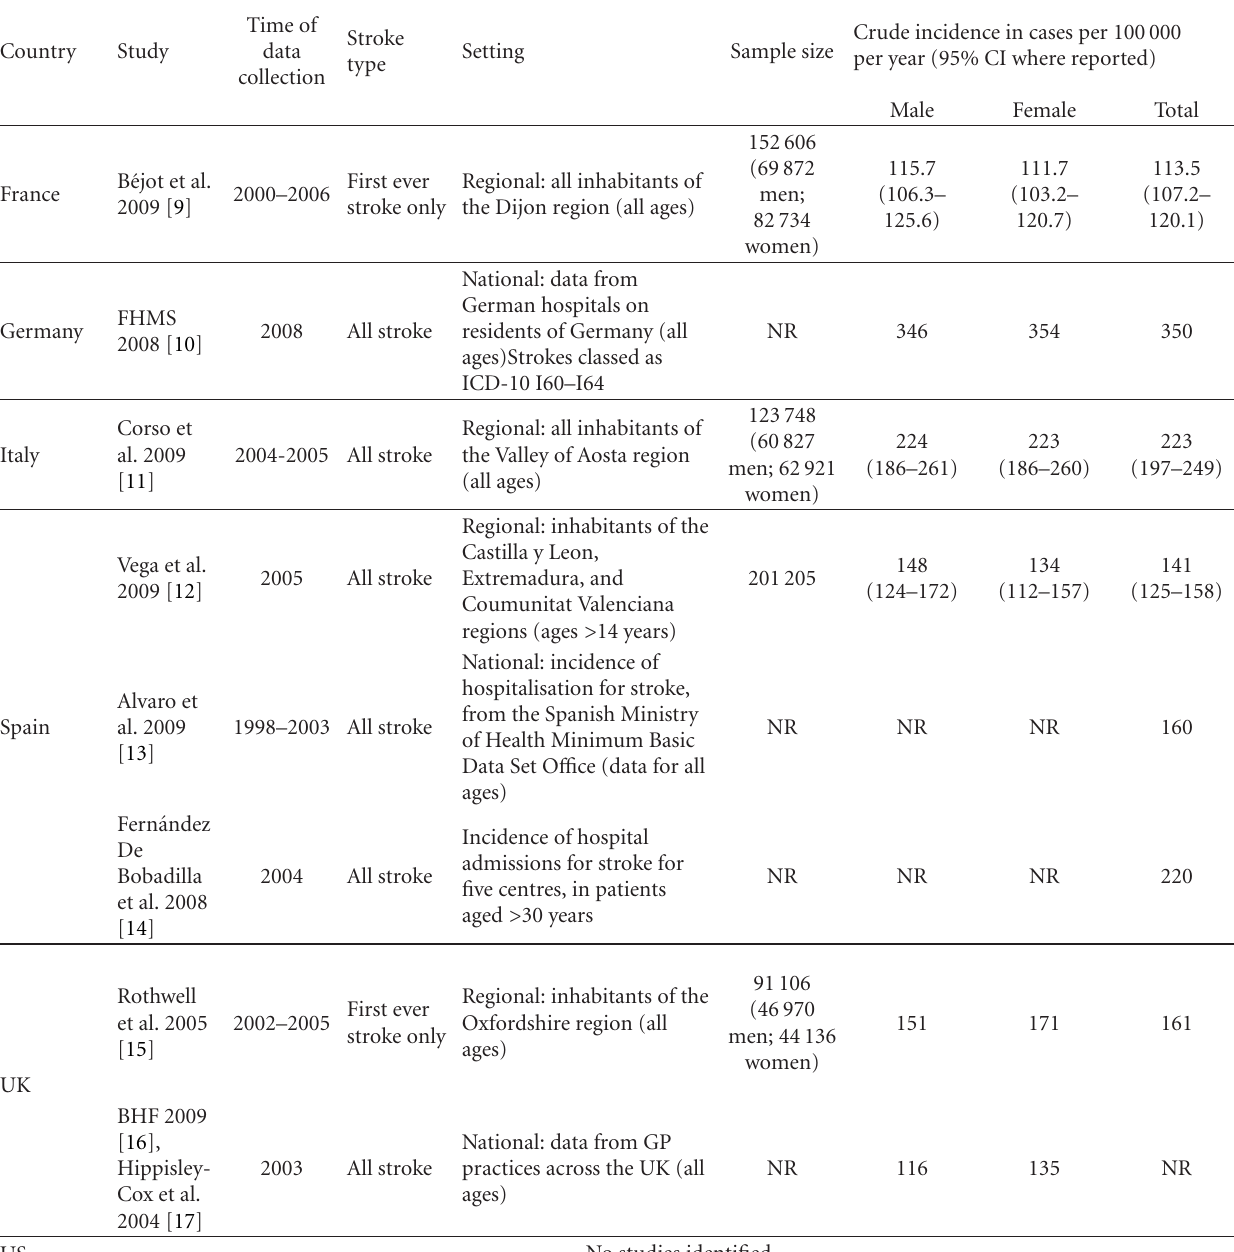
Table 1: Studies reporting incidence of stroke (any